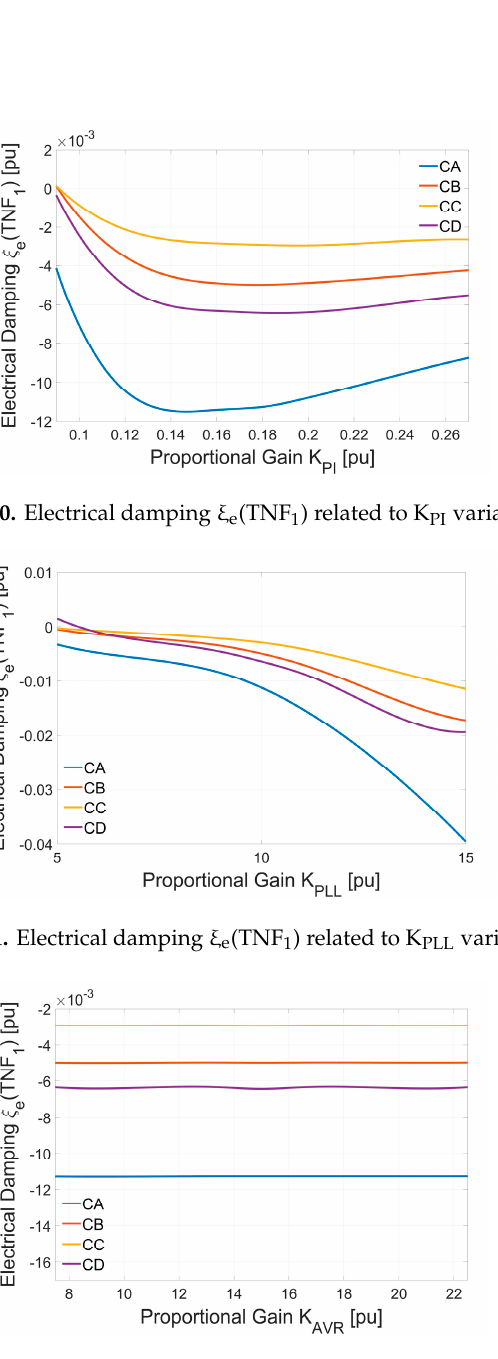
Figure 23. Electrical damping ξ e (TNF 1 ) related to K PSS variations. Figure 25. Sensitivity coefficient of electrical damping ξ e (TNF 1 ) related to K PLL .